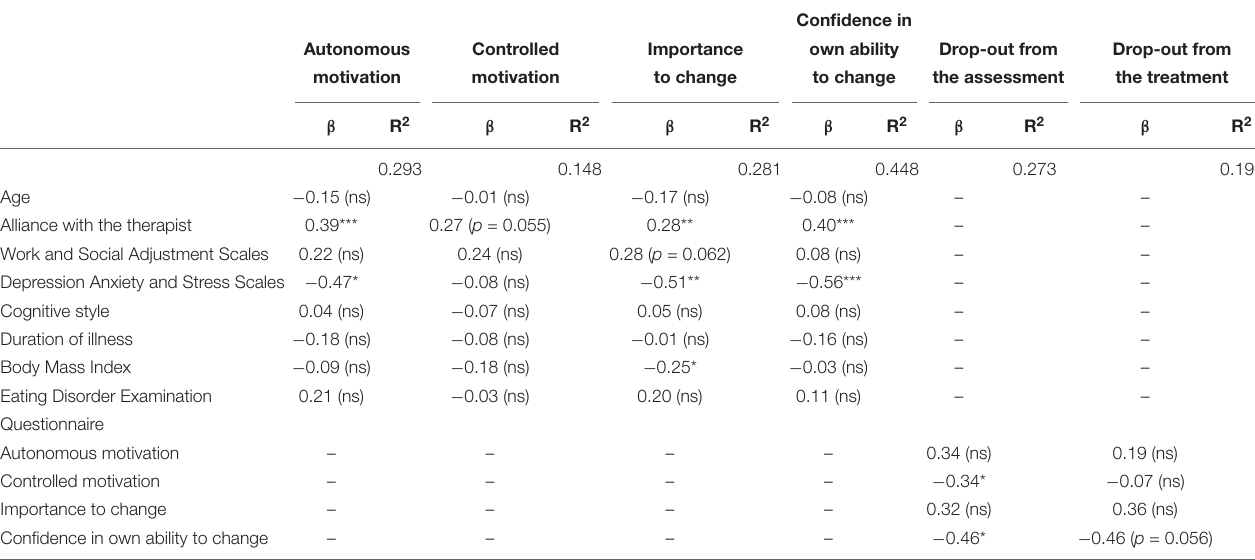
TABLE 3 | Standardized coefficients of the structural equation